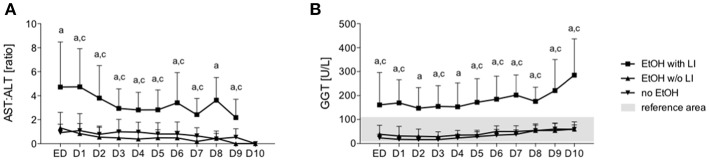
Ratio of aspartate aminotransferase (AST) to alanine aminotransferase (ALT) and levels of gamma-glutamyl transpeptidase (GGT) in trauma patients. Upon admission of severely injured trauma patients to the emergency department (ED) up to 10 days after admission, AST, ALT, and GGT were measured. Ratio of AST to ALT is shown (A) and GGT levels (B). EtOH, ethanol; EtOH with LI, alcohol drinkers with liver injury; EtOH w/o LI, alcohol drinkers without liver injury; no EtOH, non-drinkers. Data are presented as mean ± SD. *p < 0.05 in a, EtOH with LI vs. no EtOH; b, EtOH w/o LI vs. no EtOH; and c, EtOH with LI vs. EtOH w/o LI.